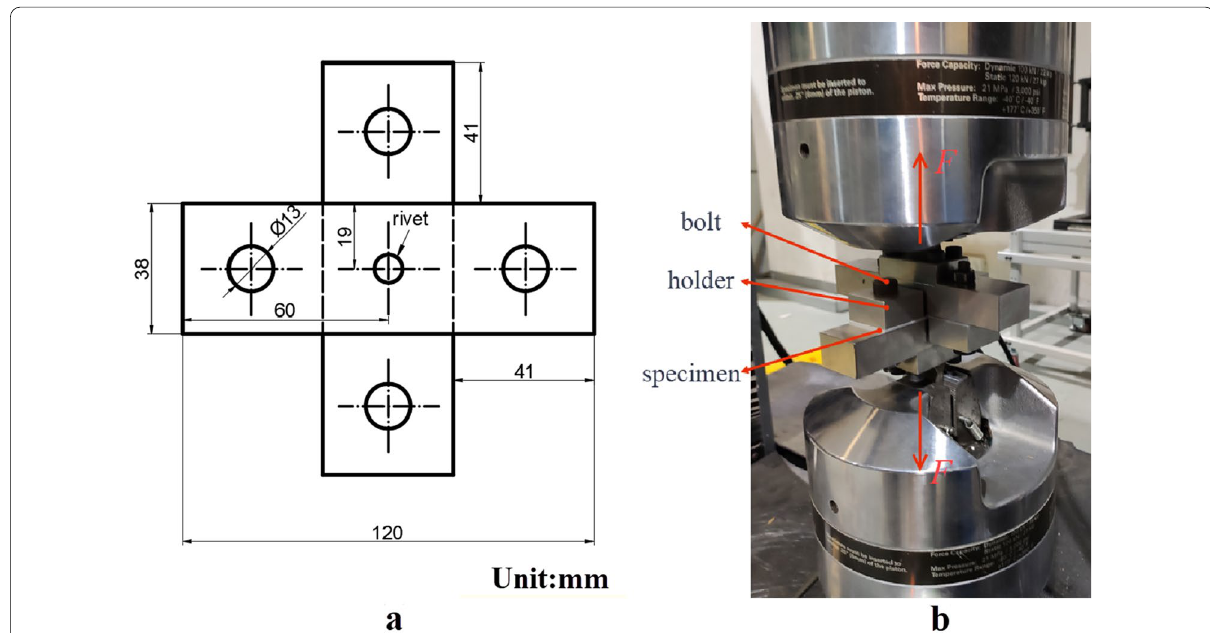
Figure 2 Schematic dimension of specimen and optical image of test setup ( a ) dimensions of cross-tension joint, ( b ) cross-tension test setup